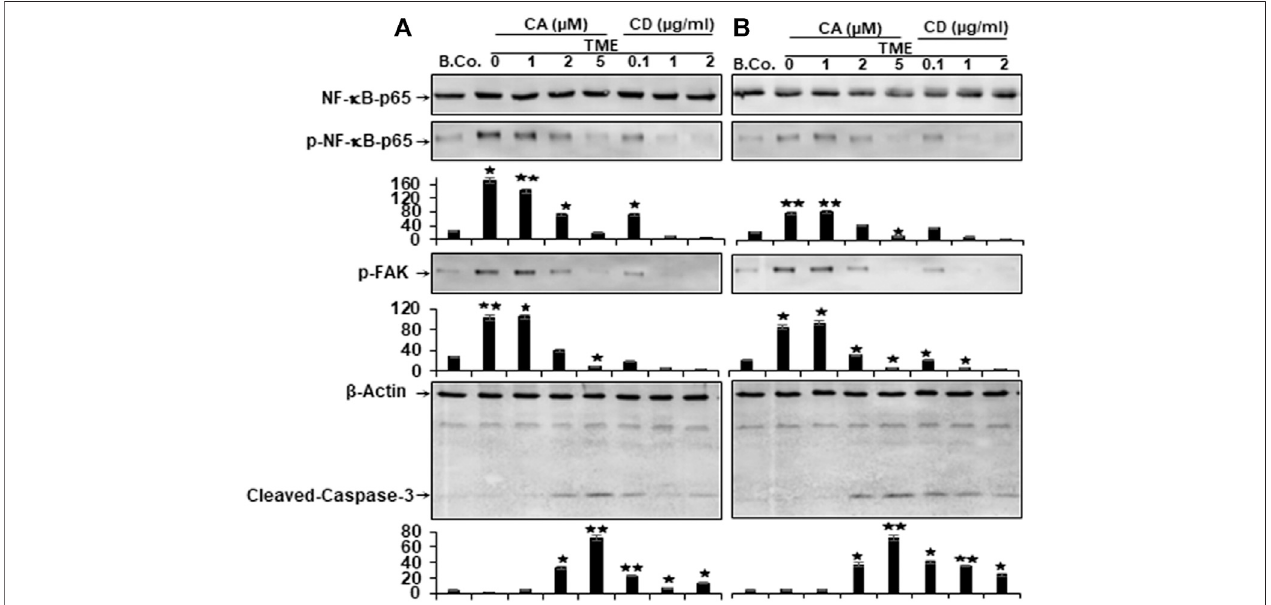
FIGURE 4 | Calebin A or cytochalasin D actions on NF- κ B, FAK, and caspase-3 expression in colorectal cancer cells. (A) HCT116 and (B) RKO cells in alginate beads (B. Co.) or in TME were kept by themselves or treated with variable amounts of Calebin A (CA) (1, 2, and 5 μ M) or cytochalasin D (CD) (0.1, 1, and 2 µg/ml) for 10 daysasoutlinedinMaterialsandMethods.ImmunoblottingontotalsampleswasperformedthroughWesternblottingusingantibodiestop65-NF- κ B,phospho-p65- NF- κ B, p-FAK, and Caspase-3. Indicated are the results of at least three separate assays, with β -Actin serving as control. The densitometric analysis has been carried out for the indicated proteins. * p < 0.05, ** p < 0.01 relatively to basal